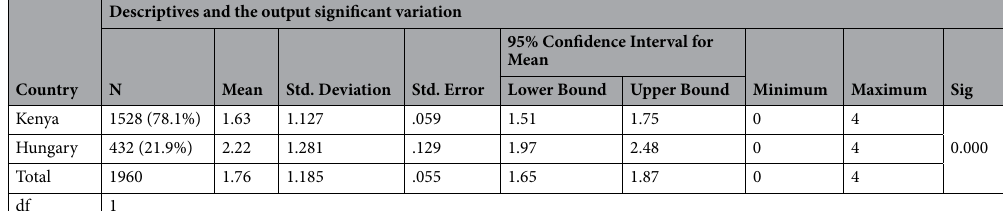
Descriptives and the output significant variation